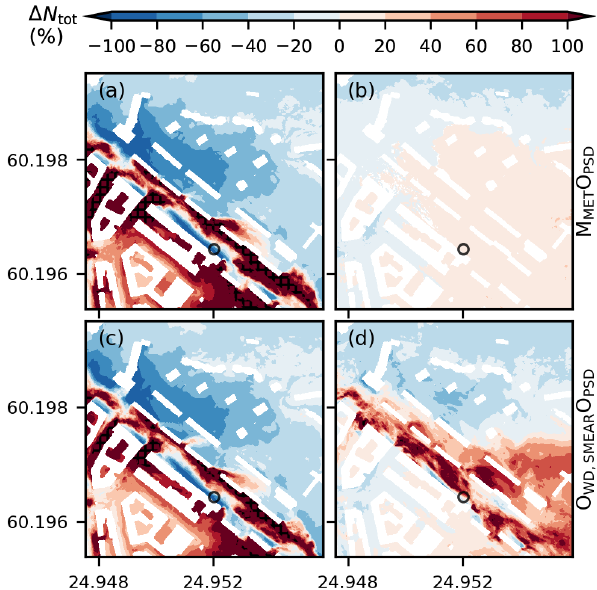
Figure 11. Relative difference in the total aerosol number concen- tration ( (cid:49)N tot ) at z = 2 . 5m on the morning of 9 June between 07:16 and 09:15LT compared to M MET M PSD for (a) O MET O PSD , (b) M MET O PSD , (c) O WD , mast O PSD and (d) O WD , SMEAR O PSD . The area with black crosses shows | (cid:49)N tot | > 150%. Buildings shown with white and black circles denote the locations of the su- persites. Note that (cid:49)N tot is shown here for the whole simulation and not separately for each